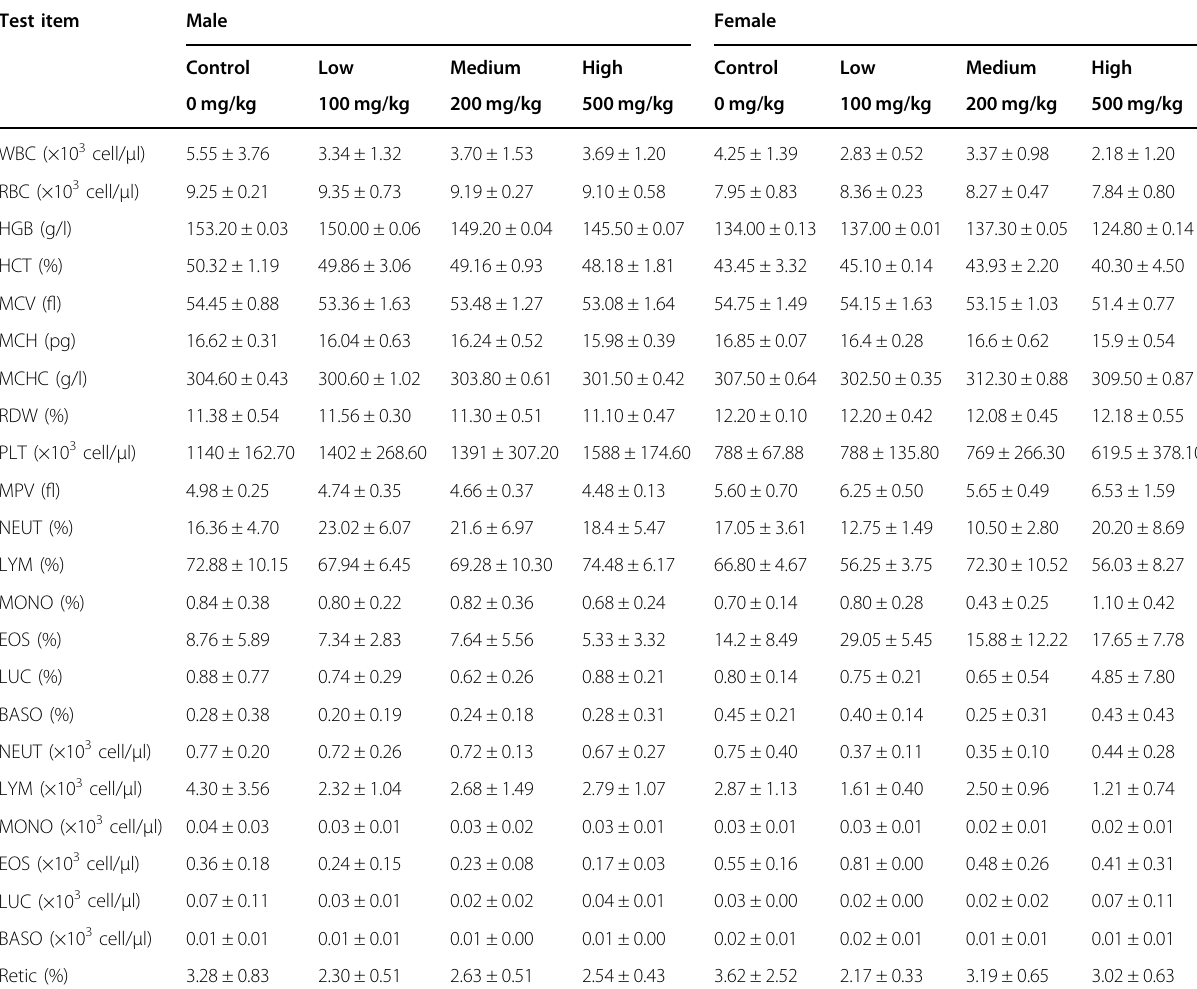
Table 2 Hematological analysis for male and female mice in single dose toxicity study Test